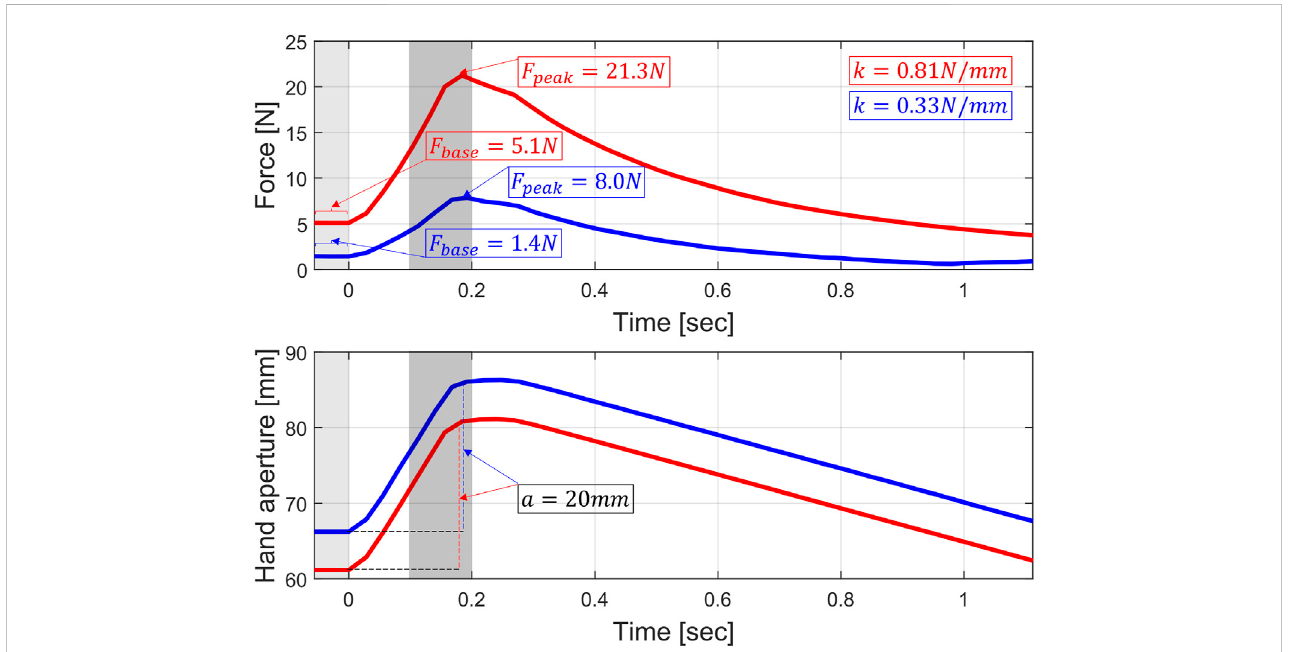
Representativefast20 mm(amplitude a ,thumbtoindextipdistancechange)ramp-and-holdperturbationfromsubjecttwointhestrokegroup(red)and subject fi veintheunimpairedgroup(blue). Inlightgreyisthe50 mswindowinwhich theaveragebaselineforce(F peak )iscalculated beforetheramponset. In grey is the 100 ms window in which the maximum force peak induced by the perturbation (F base ) is